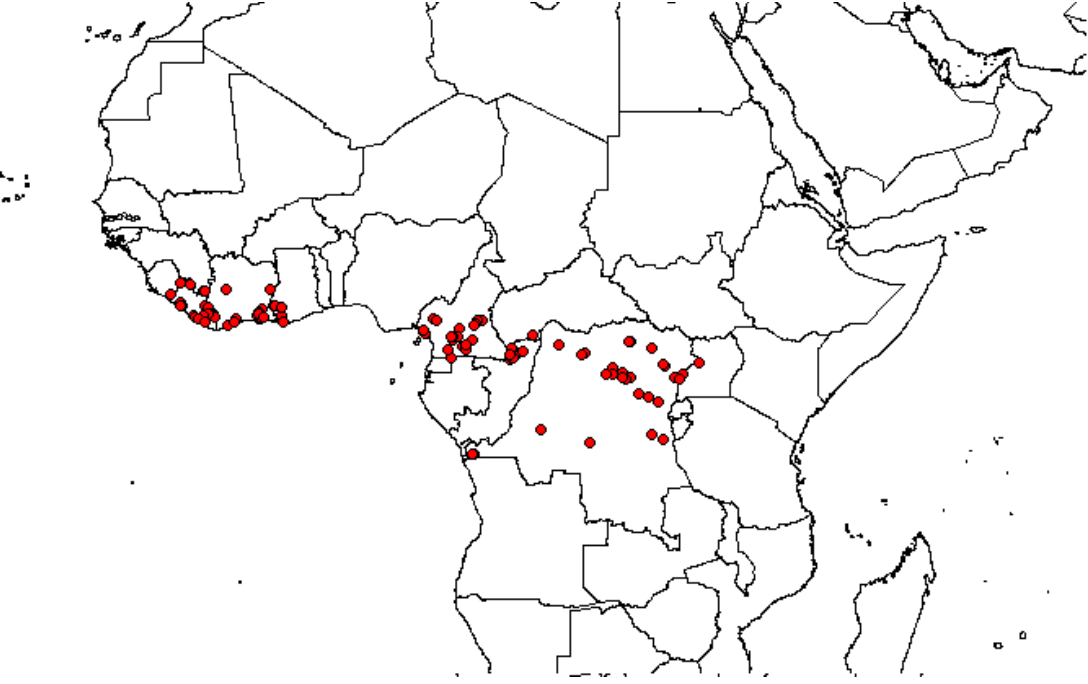
Fig. 5. Distribution map for Desplatsia chrysochlamys (Mildbr. & Burret) Mildbr. &